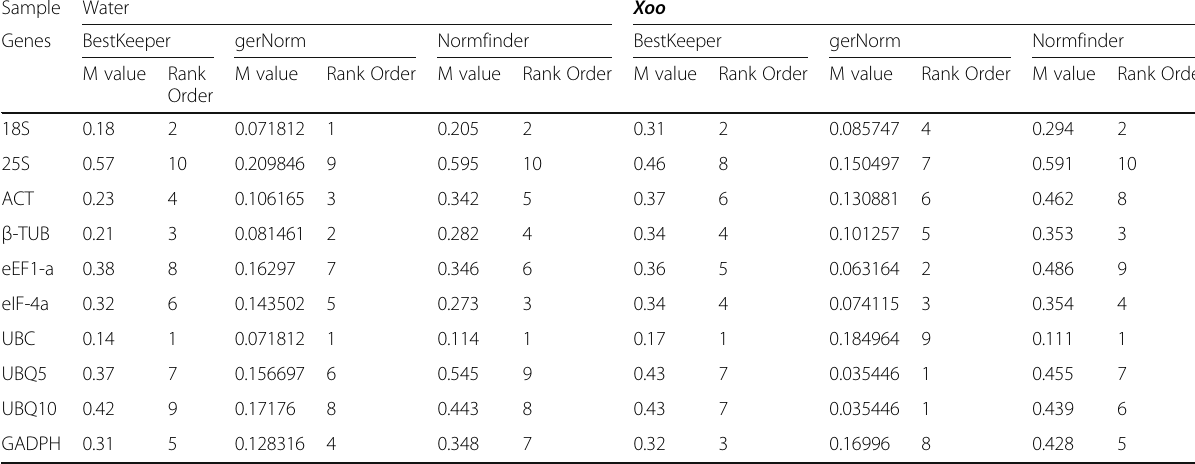
Table 4 Ranking of the candidate reference genes according to their stability value calculated using geNorm, Normfinder and Bestkeeper in PX099-infected rice plant Sample